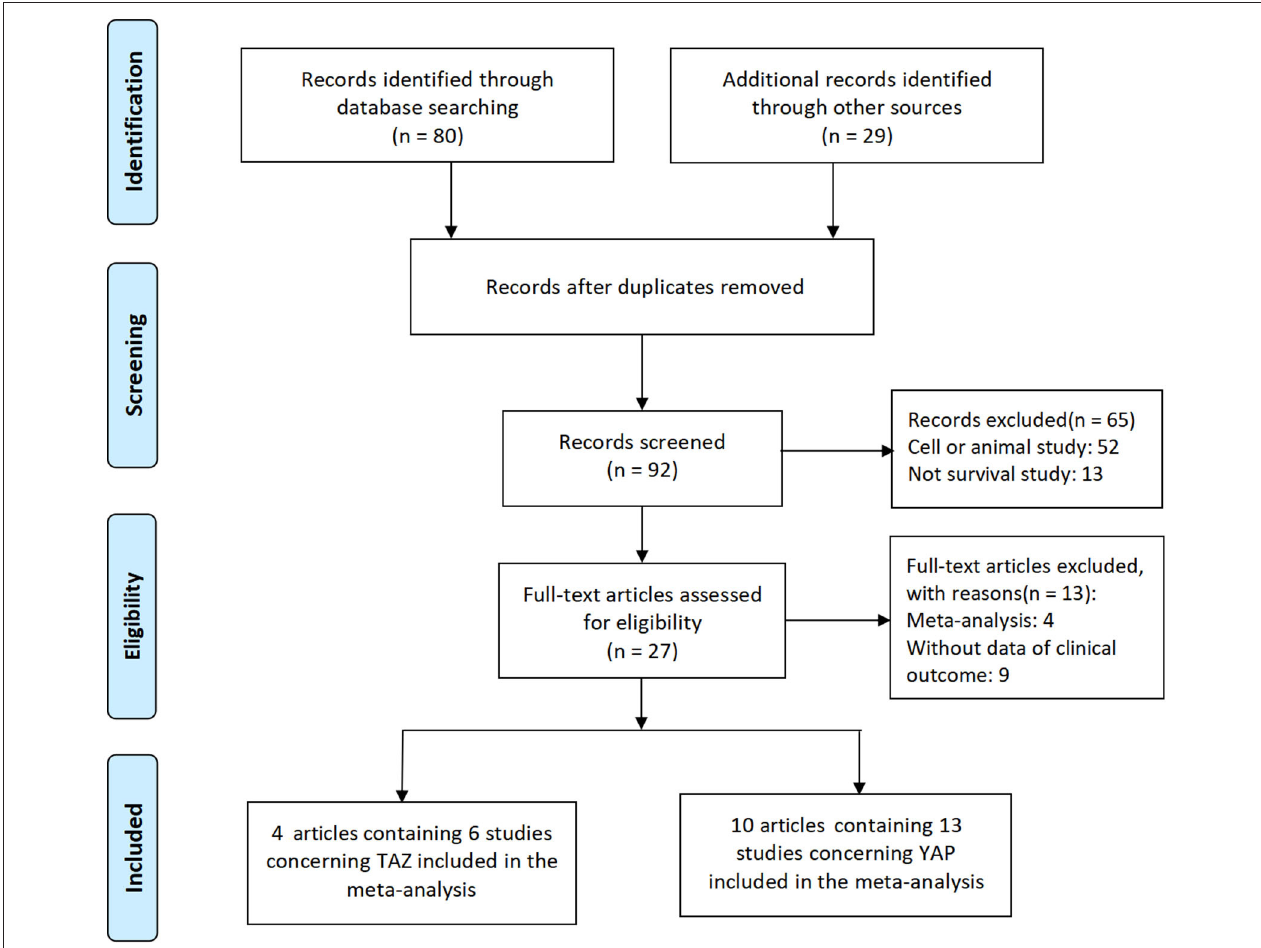
FIGURE 1 | The screening and identification of studies included in this